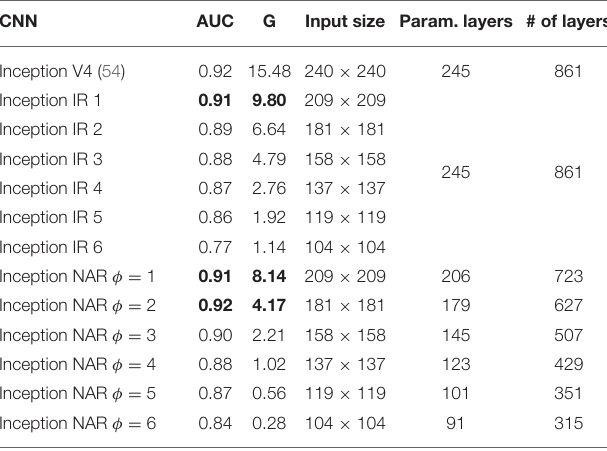
TABLE 4 | AUC, Giga-FLOPs (GFLOPs) correspondent to input sizes, number of parameter layers, and total layers of Inception V4 and simplified networks produced by